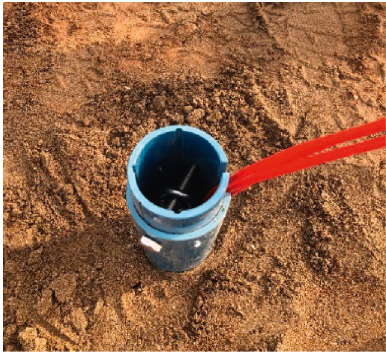
Figure 4: Burying the